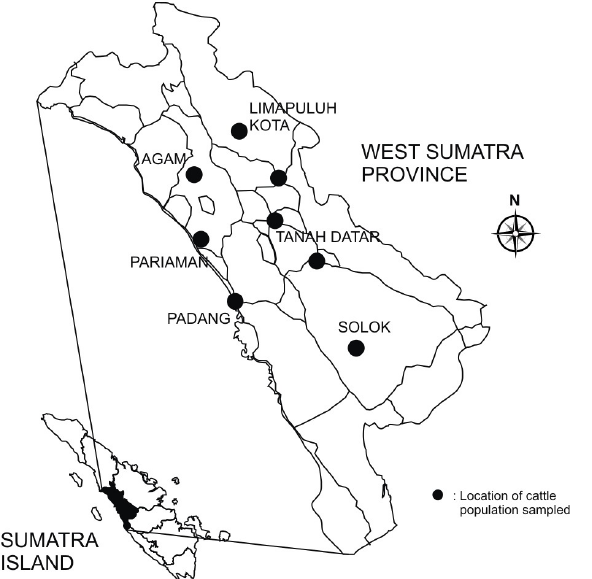
Figure 1. Geographical distribution of the Simmental Cross cattle in West